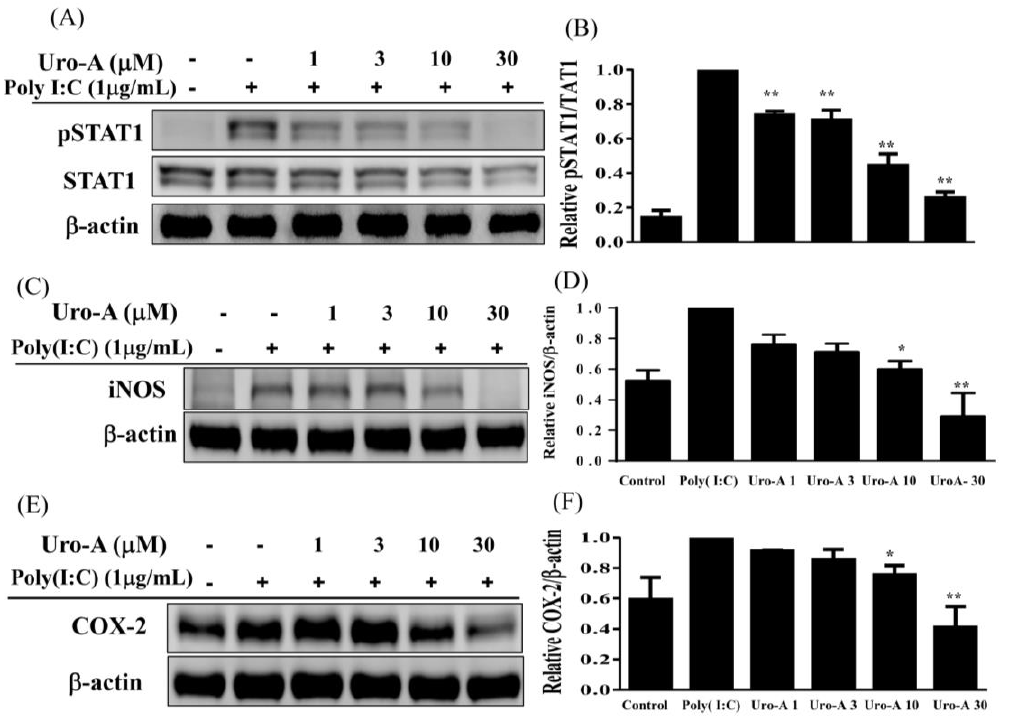
Figure 4. Urolithin A (Uro-A) inhibited the expression of inflammatory mediators in poly(I:C)- induced RAW264.7 cells. ( A ) pSTAT1 and STAT1 protein expression. ( B ) Fold-change in pSTAT1 expression relative to STAT1 expression. ( C ) iNOS protein expression. ( D ) Fold-change in iNOS expression relative to β -actin expression. ( E ) COX-2 protein expression. ( F ) Fold-change in COX-2 expression relative to β -actin expression. RAW264.7 cells were precultured with various concentra- tions of Uro-A, and then incubated with poly(I:C) (1 μ g/mL) for 30 min or 24 h. Data are presented as mean ± SD. * p < 0.05, ** p < 0.01 compared to RAW264.7 cells stimulated with poly(I:C) alone.